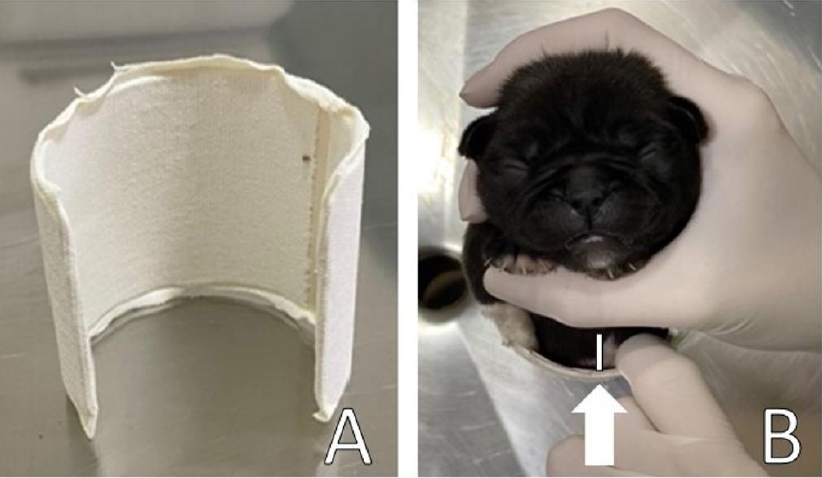
Figure 5. ( A ) PVC pipe used for making the splint; ( B ) Ventral space (2 cm) necessary for remodeling the thorax (arrow) and use of cotton to upholstery the sides of the splint. The splint was upholstered with cotton wool and medical tape on the sides to support and slightly compress the sides of the chest, as well as to avoid traumatic injuries to the patient, promoting comfort in a certain way. The splint was placed on the newborn ’ s chest, with the open part of the PVC on the patient ’ s back and fixed with medical tape bandage (Figure 6).